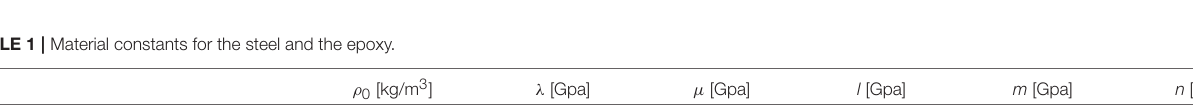
FIGURE 2 | Unit cell of steel cylinders embedded in an epoxy matrix: undeformed geometry (A) and deformed geometry corresponding to isotropic traction (B) and compression (C) . The deformation scale is amplified of 20 times.